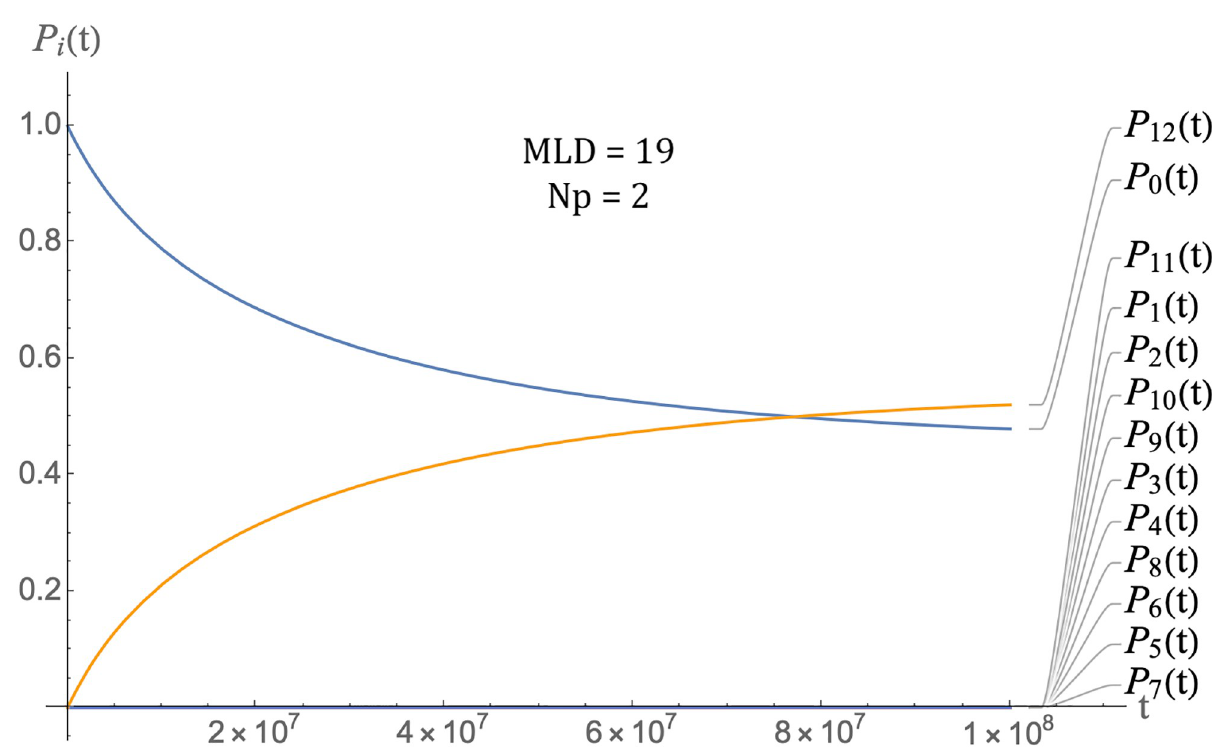
Fig 8. Packaging kinetics of MLD = 19, N p = 2 spanning trees with the same parameters as those of the previous figure.